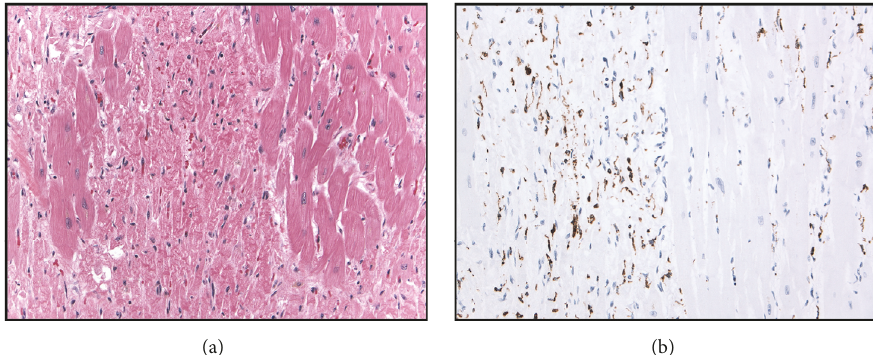
Figure 2: Myocardium of left ventricle. (a) H&E stain showing patches of normal appearing myocardium (right and left) separated by areas of confluent myocardial necrosis (center). (b) Immunostain for CD68 showing infiltrate of macrophages in necrotic areas (on left of field), with sparing of the intact myocardium.